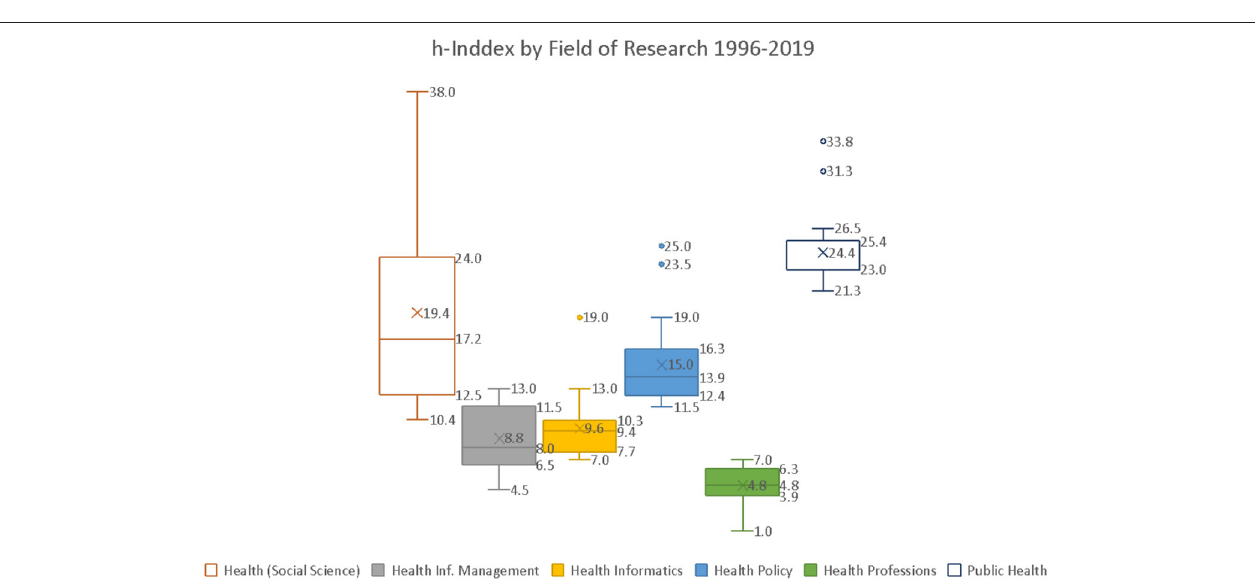
FIGURE 3 | h-Index by the field of research